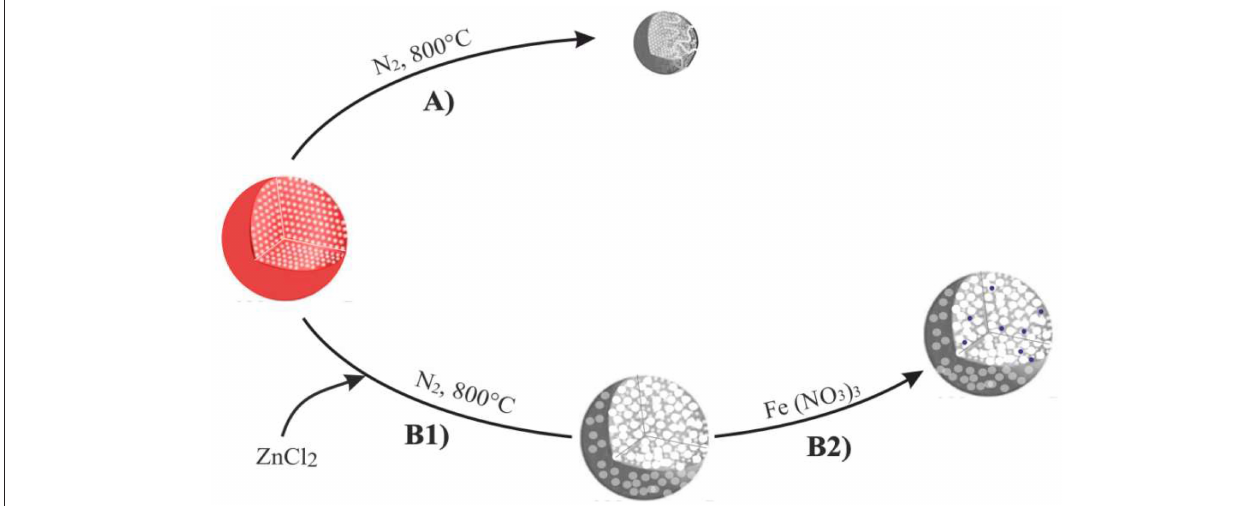
Figure 2 . A polymer sphere, showing cracks and an apparently smoothed surface (SEM images in Figures 2a,a ′ ), reveals its ultimate nature of assembled rounded domains, with sizes in the 0.1–0.3 µ m range, as AFM imaged in Figure 2a ′′ . Some copolymer spheres are SEM imaged after pyrolysis at 800 ◦ C for 5 h ( Figures 2b,b ′ ). Together with the before observed shrinkage of particles, also the rough surface, the occurrence of deep cracks, wrinkles, and folds at the surface, can be